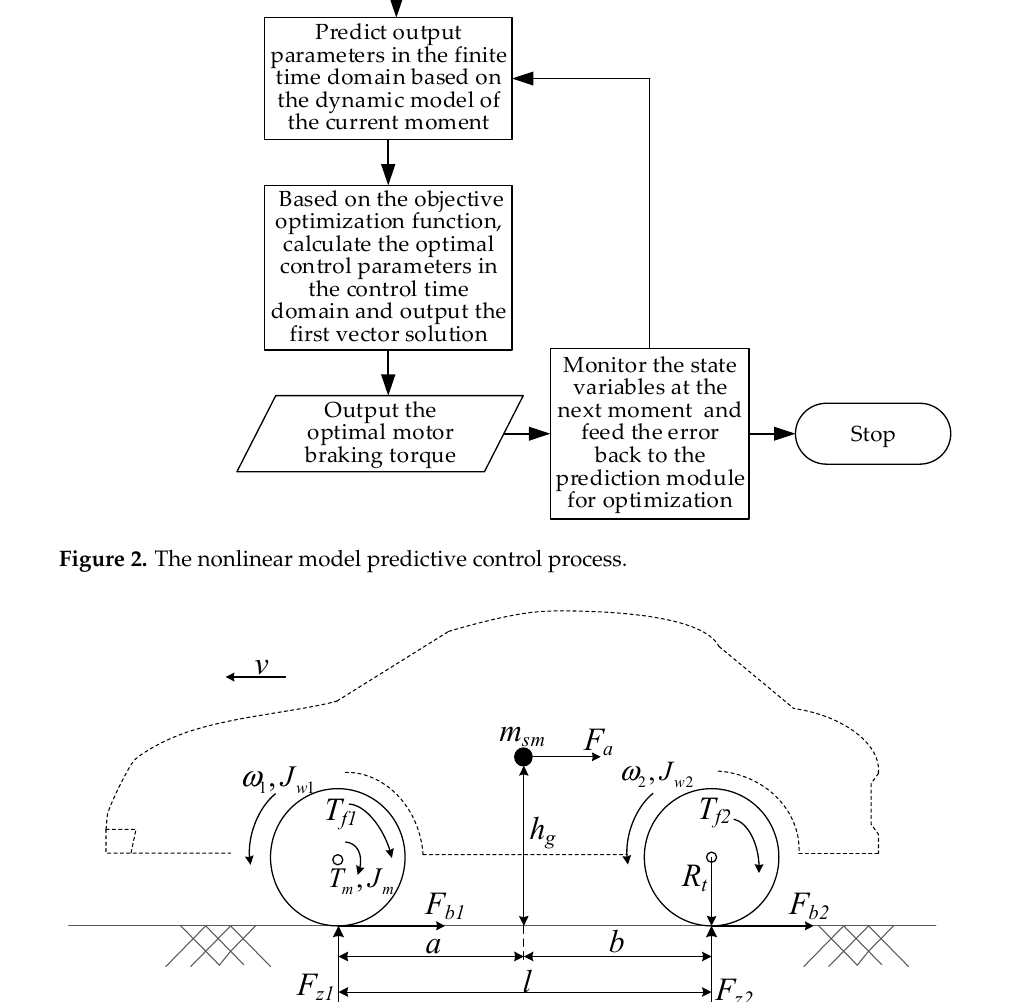
Figure 2. The nonlinear model predictive control process.